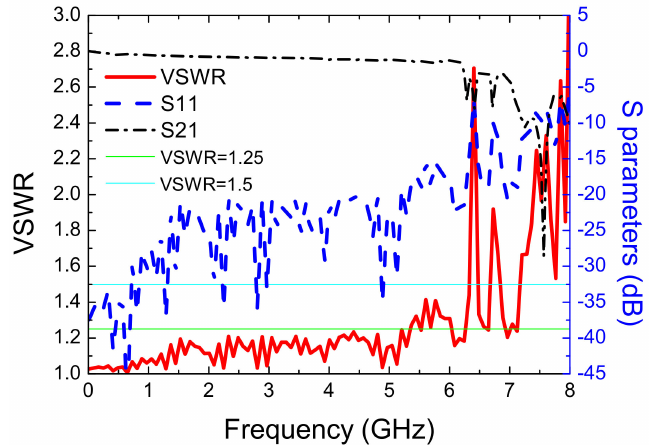
Figure 15. S-parameters and VSWR measurement results of the IC-Stripline cell based on image theory. S33 is similar to S11, and S43 is similar to